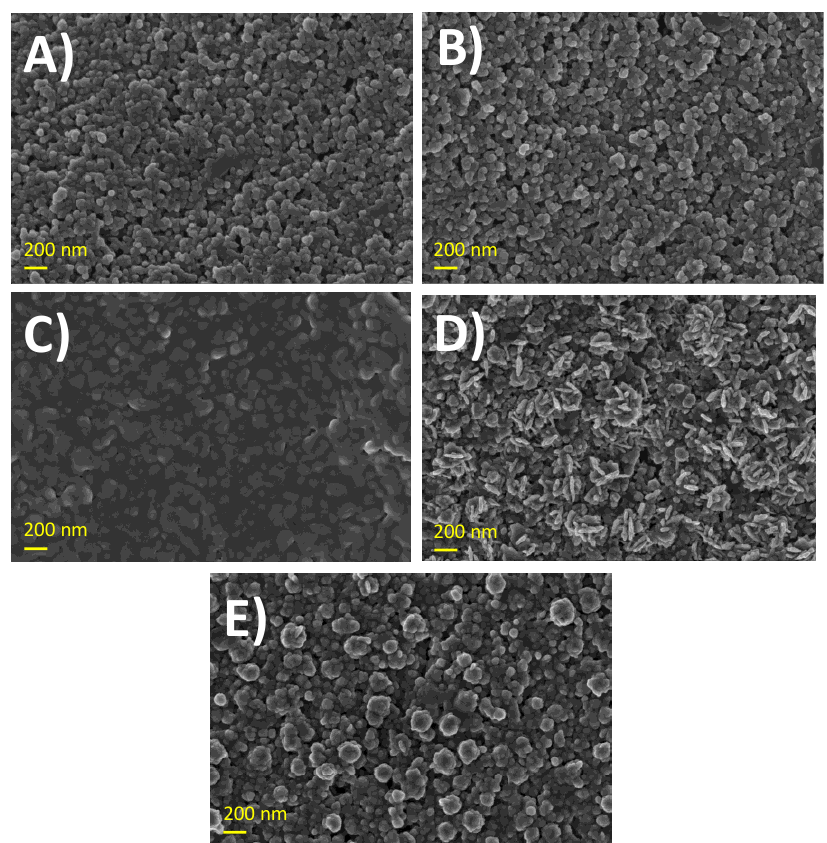
Figure 2. FE-SEM images of: ( A ) screen-printed carbon electrodes (SPCE), ( B ) activated SPCE (aSPCE), ( C ) poly(Azure A) (PAA)-aSPCE, ( D ) platinum nanoparticles (PtNPs)-PAA-aSPCE, and ( E ) glucose oxidase (GOx)-PtNPs-PAA-aSPCEs, with a magnification of 30,000 K. Theelectroactiveareasobtainedforalloftheelectrodes: